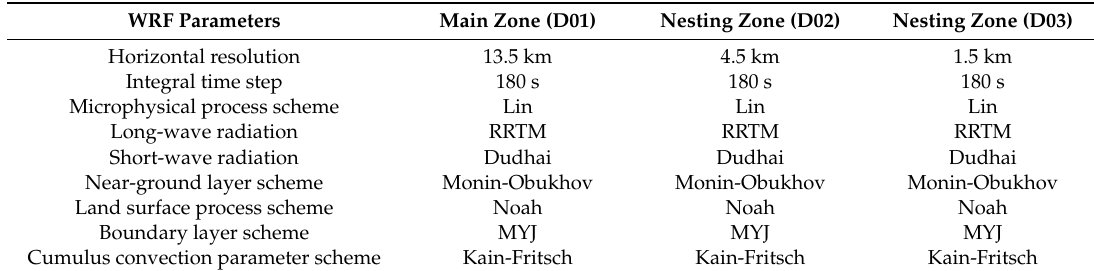
Table 1. Parameter settings of WRF mode.